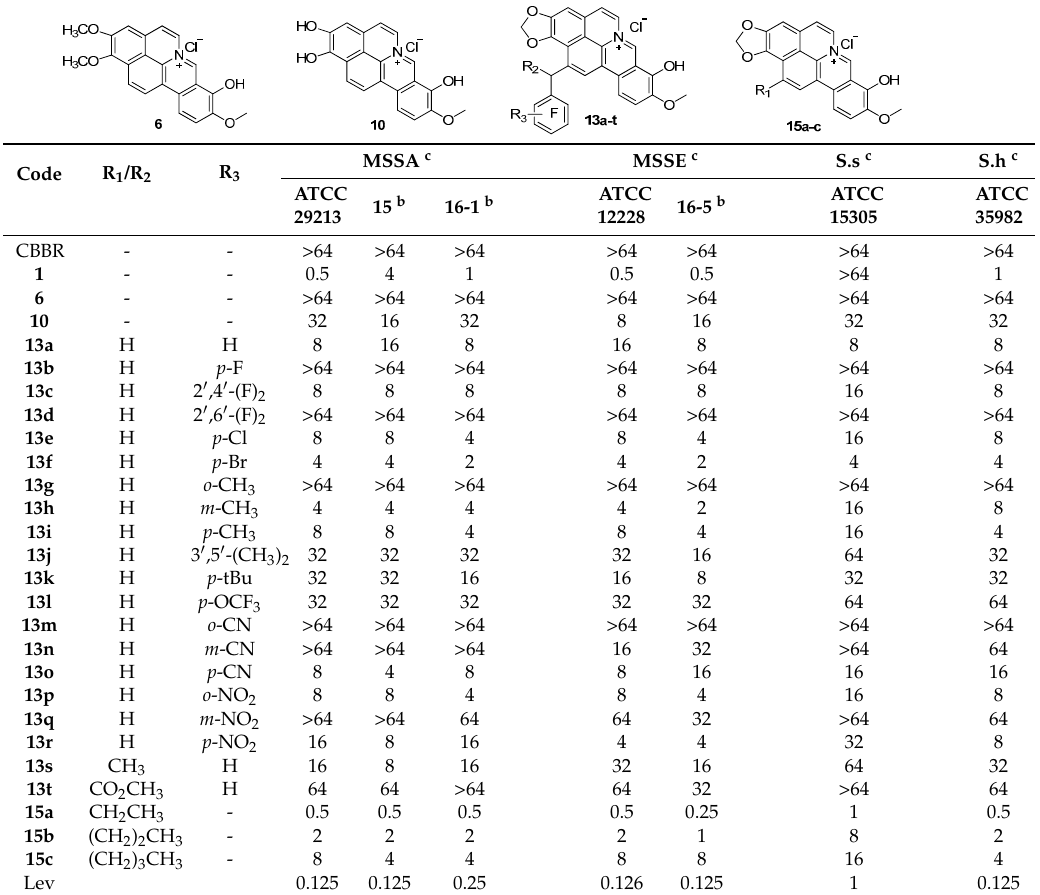
Table 1. Antimicrobial activities of the target compounds against drug-susceptible Gram-positive strains (MIC ( µ g/mL) a ).